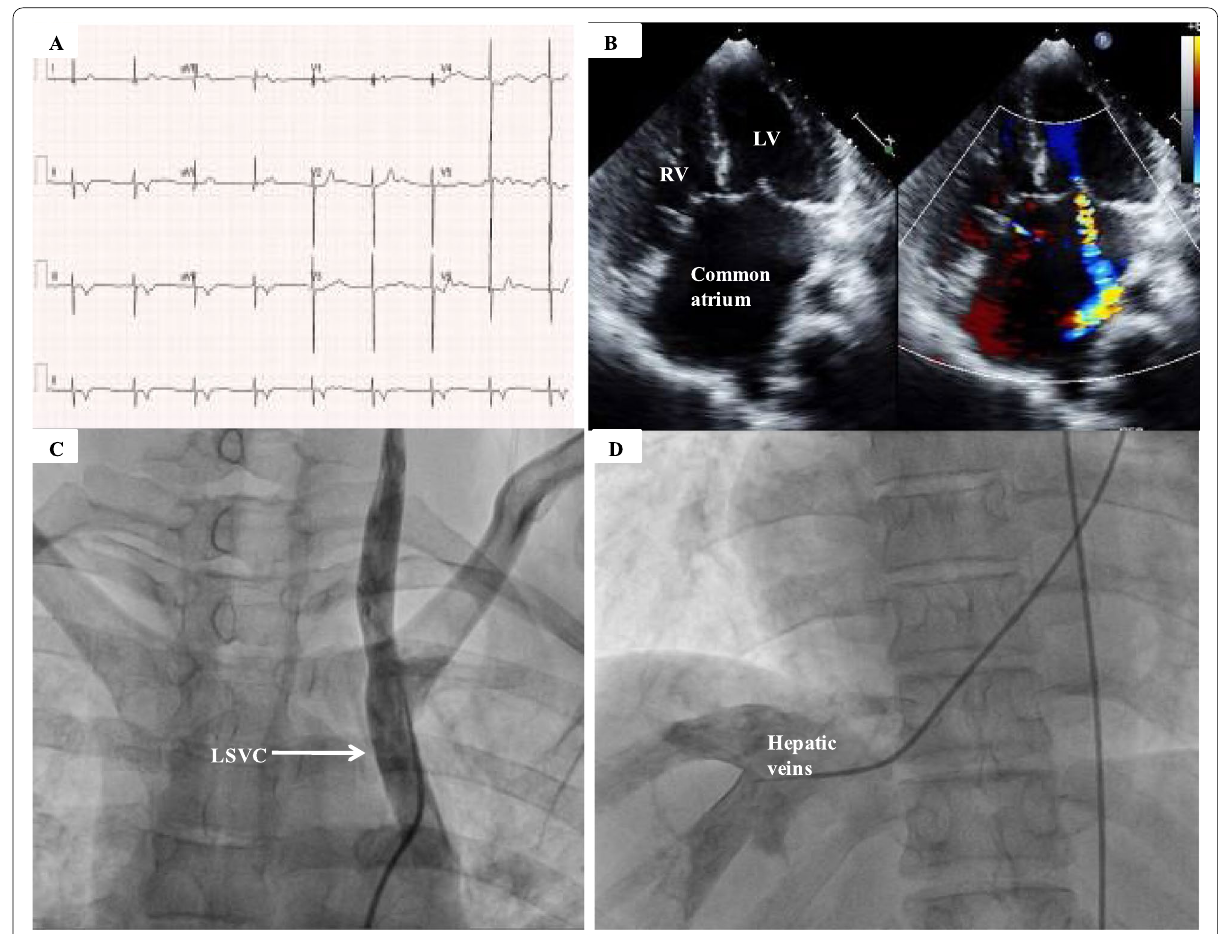
Fig. 1 A Preoperative electrocardiography showing complete heart block. B Apical 4-chamber transthoracic echocardiography showing common atrium with moderate left AV valve regurgitation. C Cardiac catheterization showing IVC continuing as hemiazygos — PLSVC and draining to left part of common atrium. D Cardiac catheterization showing catheter course: IVC — hemiazygos vein, PLSVC — common atrium — hepatic